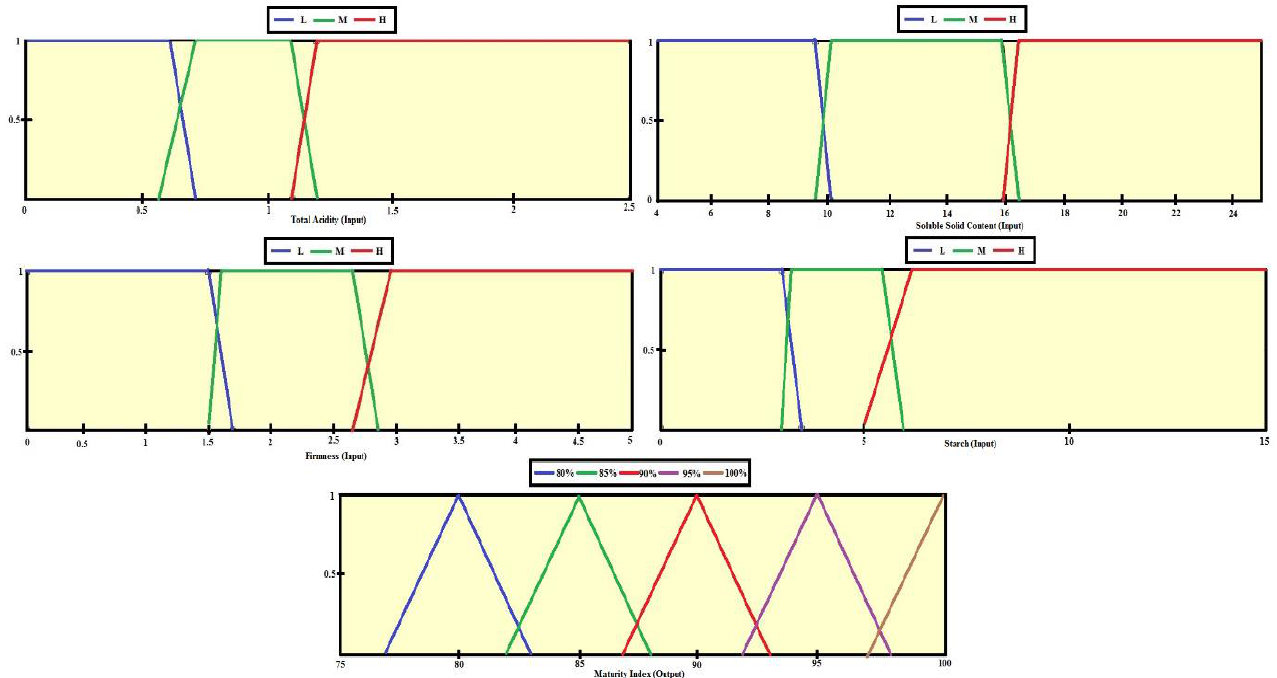
Figure 7. Membership function.